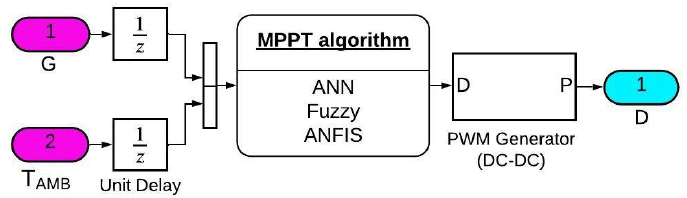
Figure 6. Scheme of MPPT with the AI algorithms.